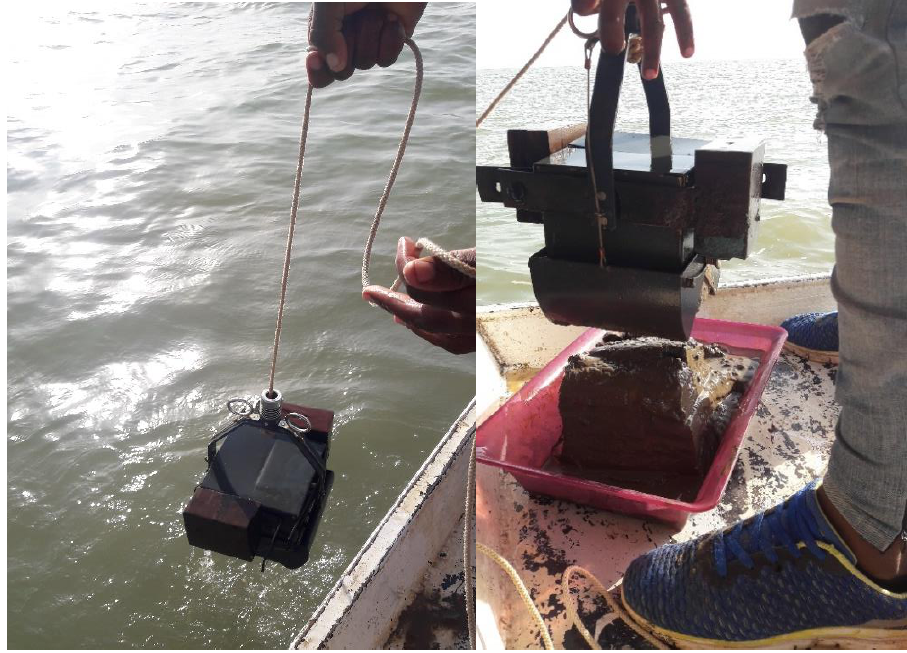
Figure 2. Bottom sediment sample collection from Lake Tana (photo taken on 3 March, 2018).